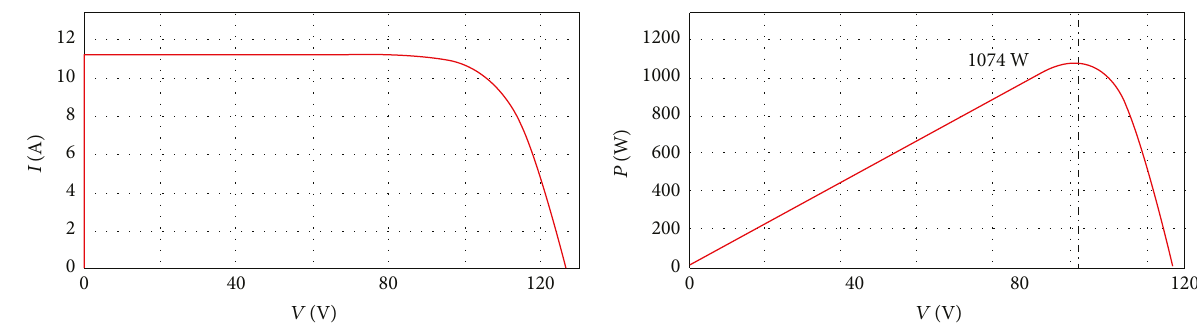
Figure 14: I ‐ V and P ‐ V curves of the PV array.